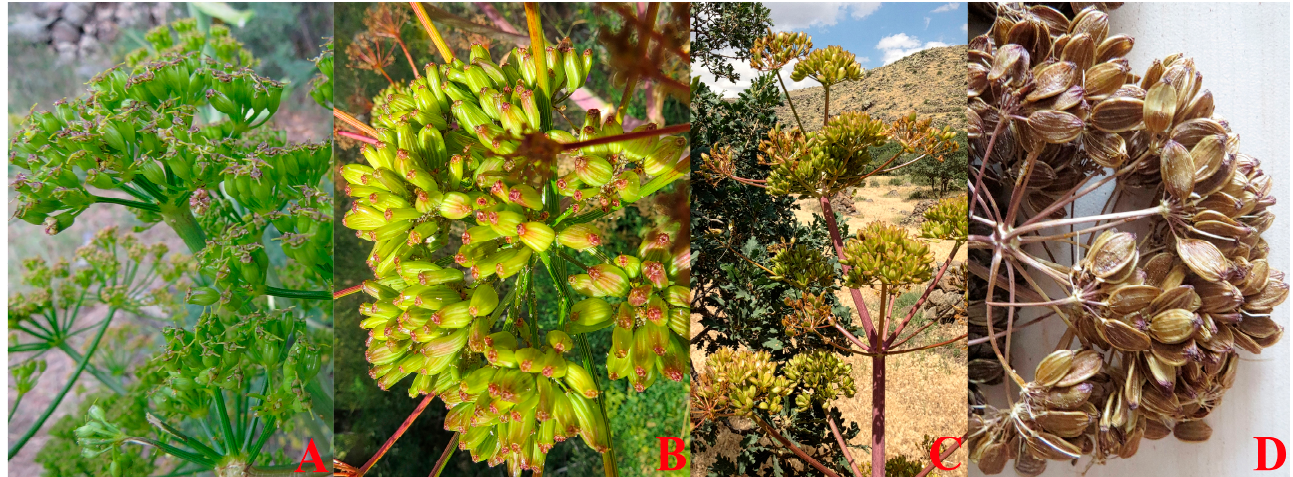
Figure 2. Fruits of Ferula drudeana during their development stages: ( A ) immature fruits, ( B ) young fruits, ( C ) maturing young fruits become yellow due to the loss of chlorophyll, ( D ) golden brown mature fruits.